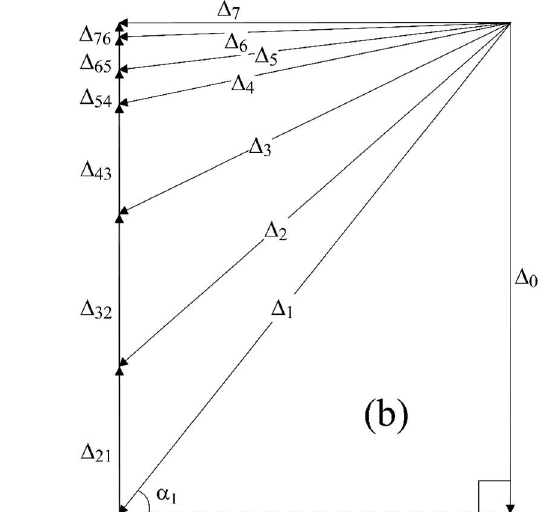
Figure 9. ( a ) Vector of displacements along failure surface and inter-slice faces for Ψ < 0 and ( b ) Hodogram for Ψ < 0.